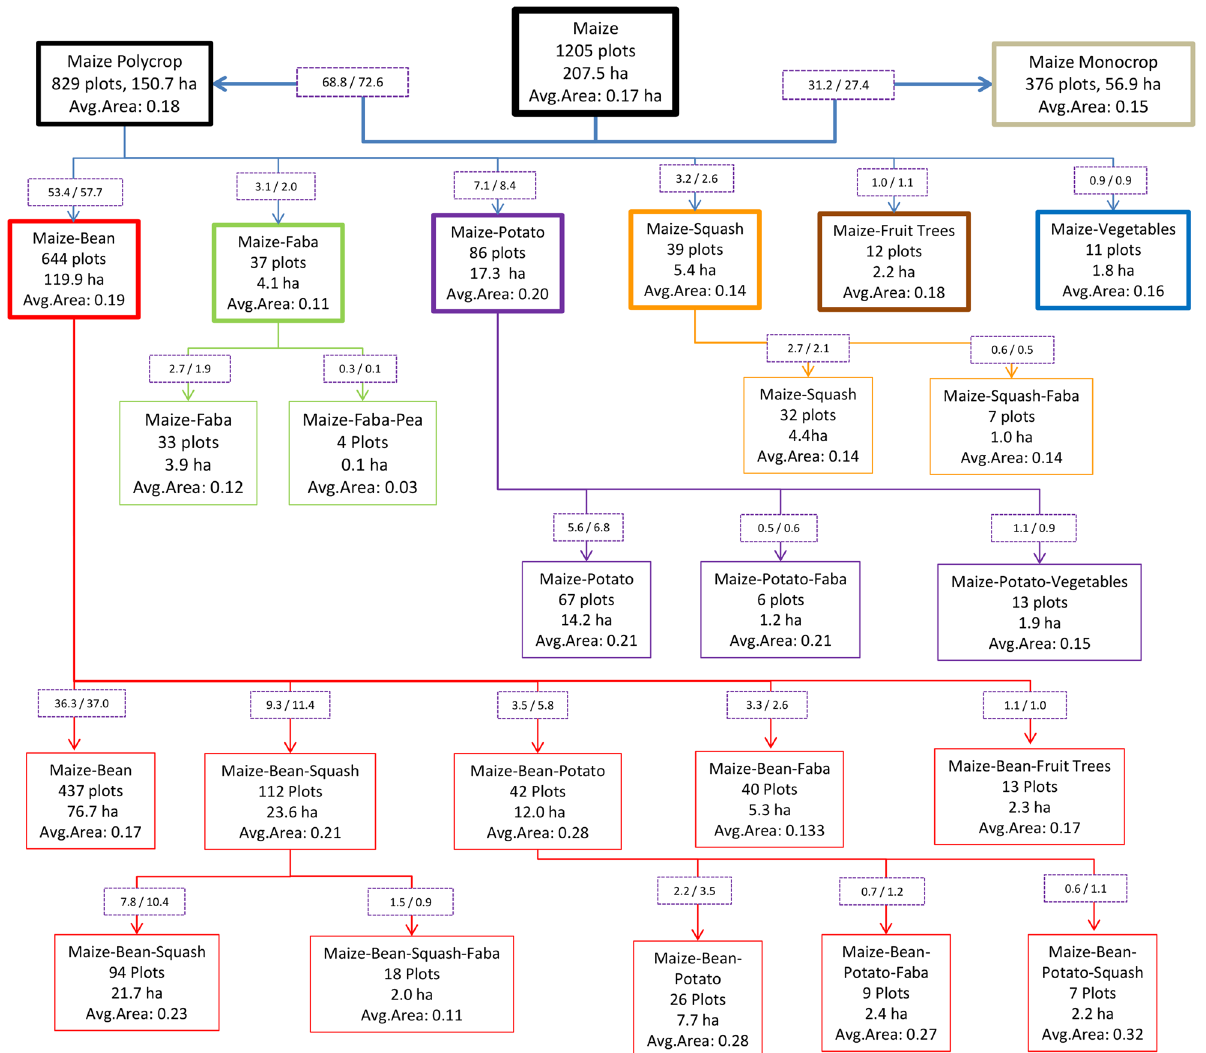
Figure 2. Maize plots reported in the survey of farm households in the Western Highlands of Guatemala. Milpa systems and their varied crop combinations are represented in different colours. The tree is nested, so the first node displays all maize plots, with successive splits for monocrop vs intercropped maize and with crop names presented according to how often they were grown (overall: maize > common beans > potatoes > squash > faba beans > fruit trees > vegetables). Numbers in the boxes superimposed on the arrows are the percentages, of number of plots and area under the respective milpa system, of the total 1 205 maize